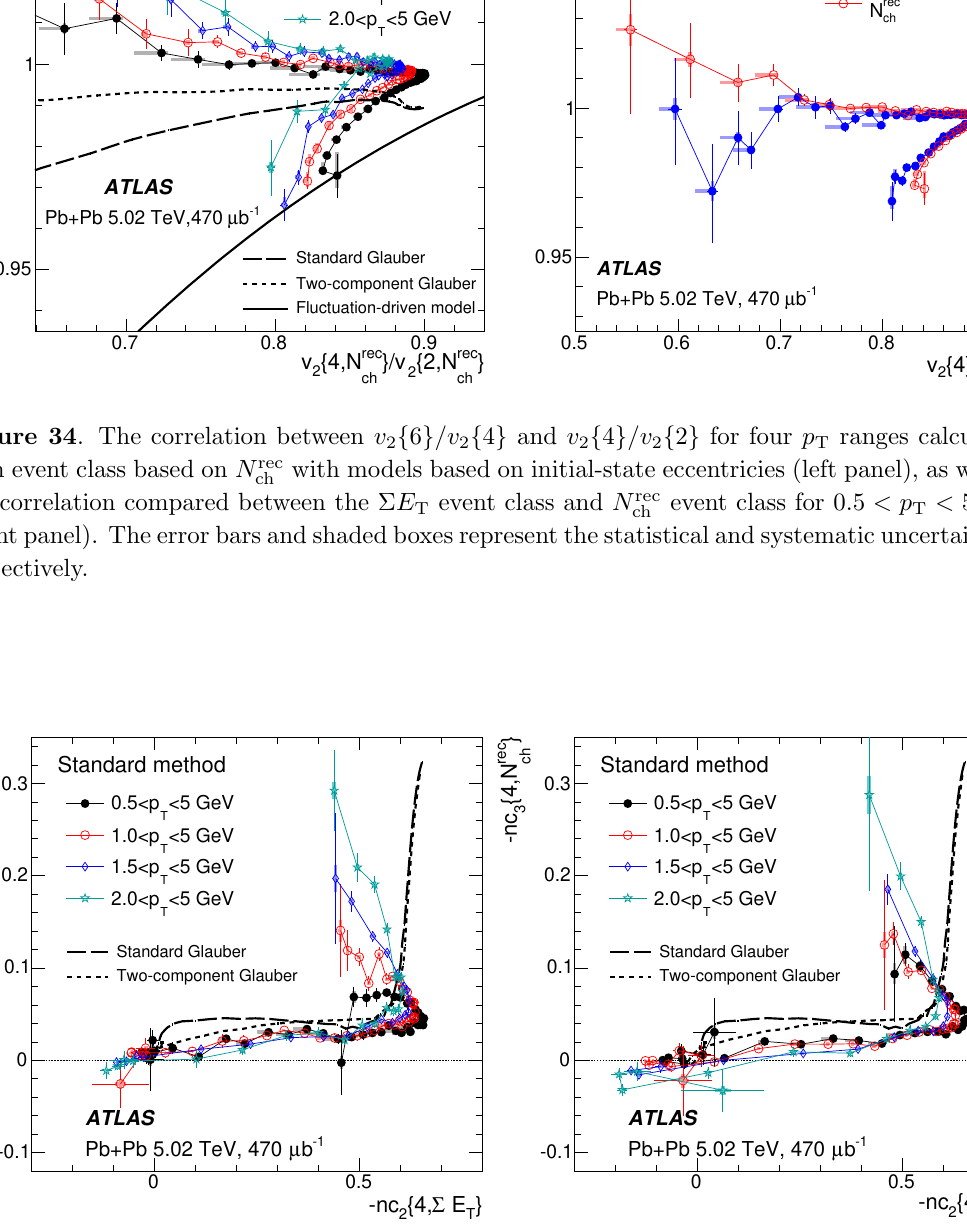
(right panel). The ch